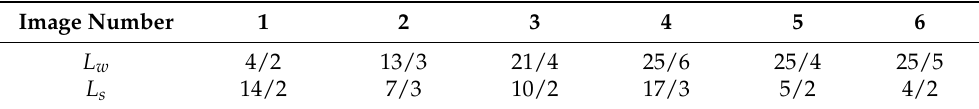
Figure 12. ( a ) Original images under WCS. ∆ t is not fixed, as the entire whitecap lifetime is to be displayed; ( b ) T h at f h = 25 Hz; ( c ) T l at f l = 6.25 Hz; and ( d ) whitecap retrieval results using our method under no sun glint conditions. Whitecap areas are shown as black pixels. Table 2. The longest trajectory lengths from whitecaps and sun glints at different sampling rates. L w represents the maximum trajectory length from whitecaps, and L s represents the maximum trajectory length from sun glints. The data format is L h / L l , which represents the trajectory lengths at high and low sampling rates,